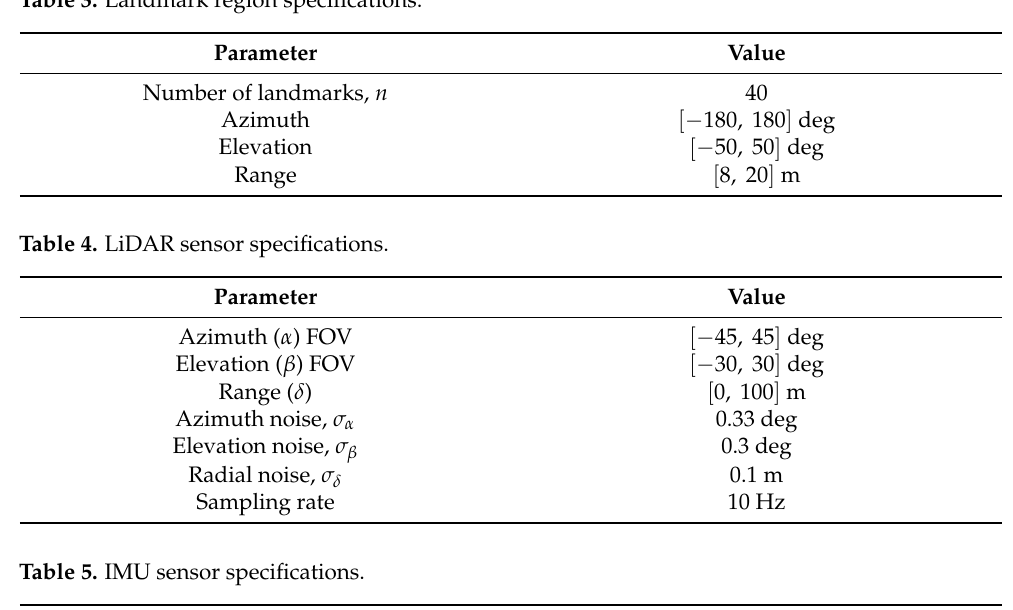
Table 3. Landmark region specifications.